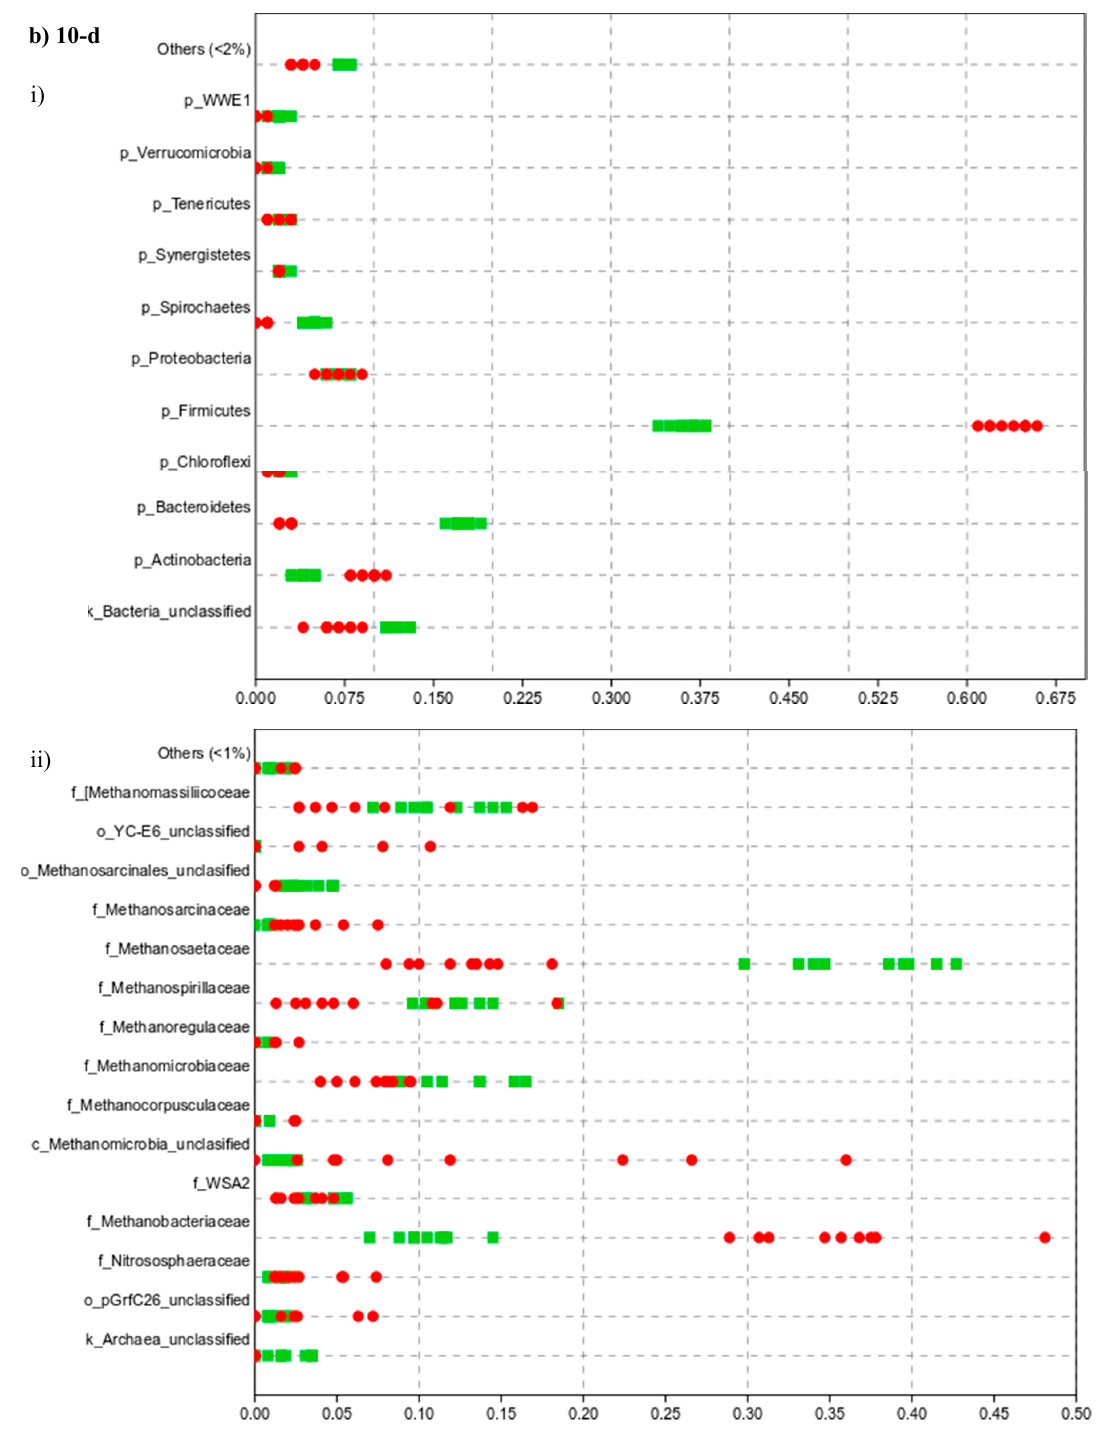
Figure 6. Jitter plot of the relative abundances of archaea at the family level (i) and bacteria at the phylum level (ii). ( a ) 28-day (above) and ( b ) 10-day (below) batch experiments. Green squares refer to the CR samples with BW and control inoculum, red dots to TH samples with BW and inoculum thermal treatment, and blue triangles to FR samples with BW and inoculum freeze-thaw treatment (for average values and statistical significance see Supplementary Material Table S1.4).